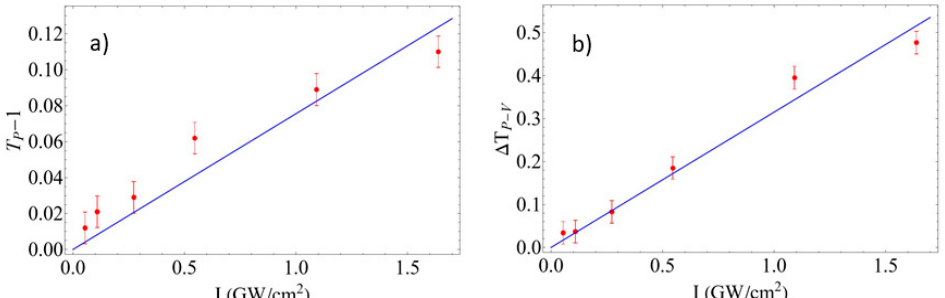
Figure 7. Dependence of the experimental z-scan signals at different input irradiance values I 0 for the SiNPs sample; ( a ) maximum transmittance change T p − 1 for the open-aperture results, and ( b ) peak to valley transmittance change ∆ T pv measured for the closed-aperture z-scan results. In both cases, linear fits to the data are also shown.